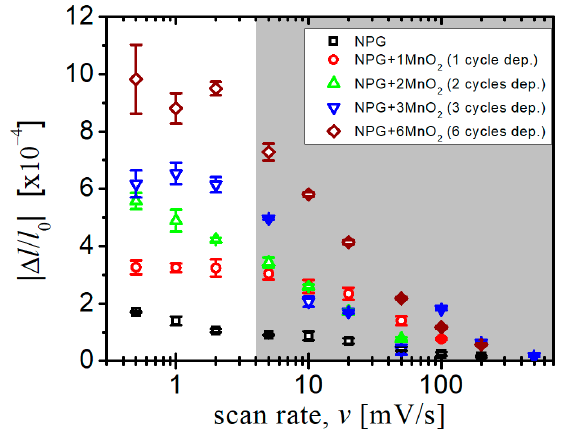
Figure 3. The actuation response as the function of electrode potential at a scan rate of 1 mV/s for npg ( a ), npg+3MnO 2 ( b ), and npg+6MnO 2 ( c ). The best linear fit is shown as red lines in the figures.